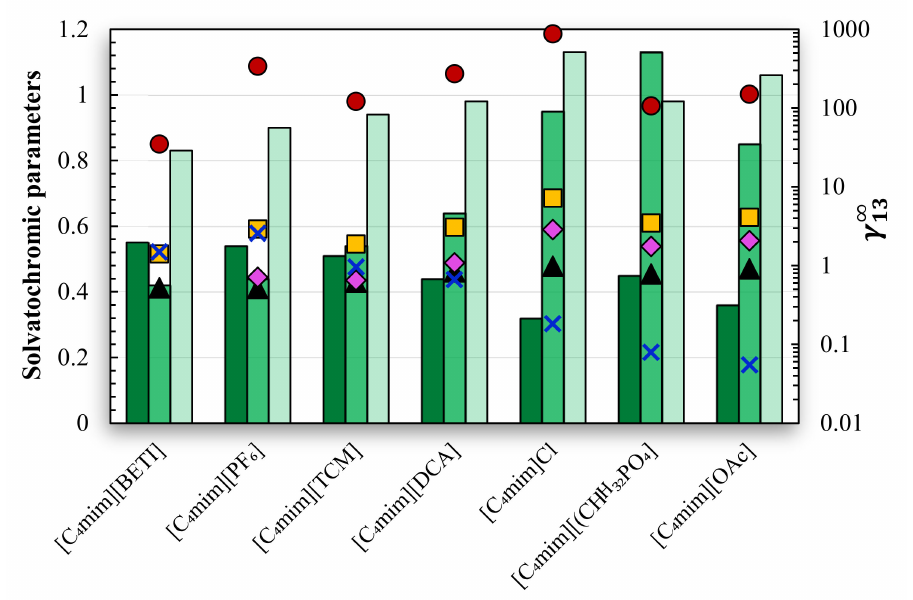
, of: • , decane; (cid:4) , toluene; (cid:78) , acetonitrile; (cid:7) , 13